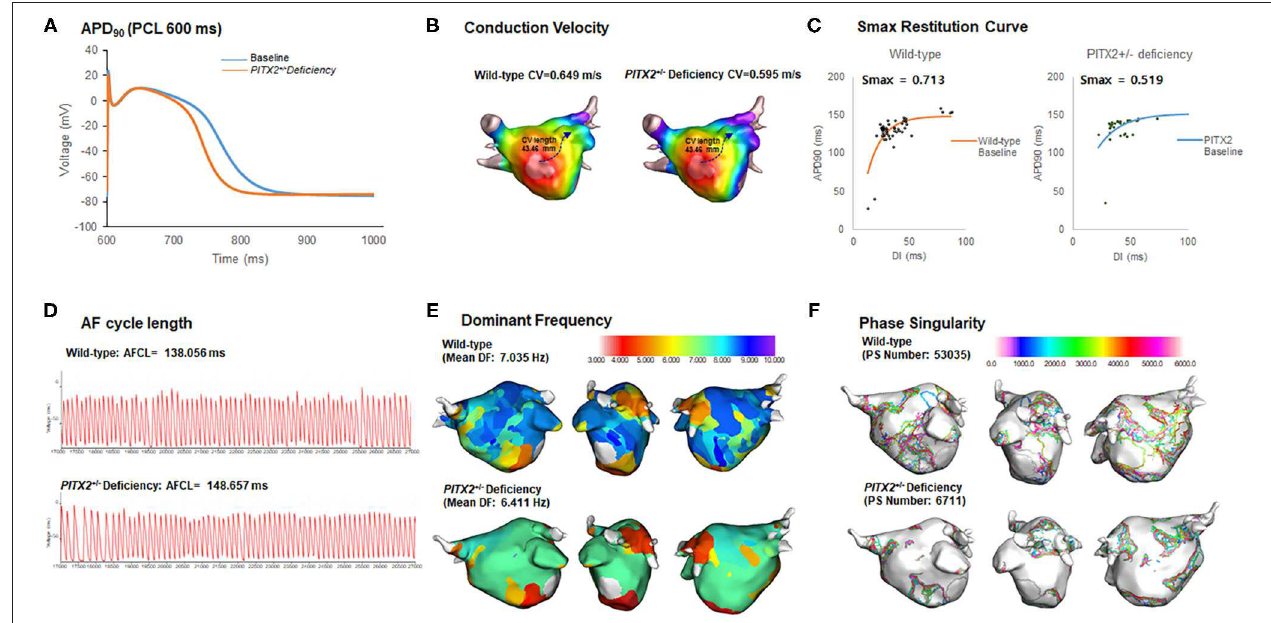
FIGURE 2 | Wild-type vs. PITX2 + / − baseline model analysis. (A–F) The baseline APD 90 , CV, Smax, AF cycle length, and wave-dynamics parameters for wild-type and PITX2 + / − deficiency were measured for a comparison. The PITX2 + / − deficiency had a shorter APD 90 (A) , lower mean Smax (C) , and PS number (F) than the wild-type.